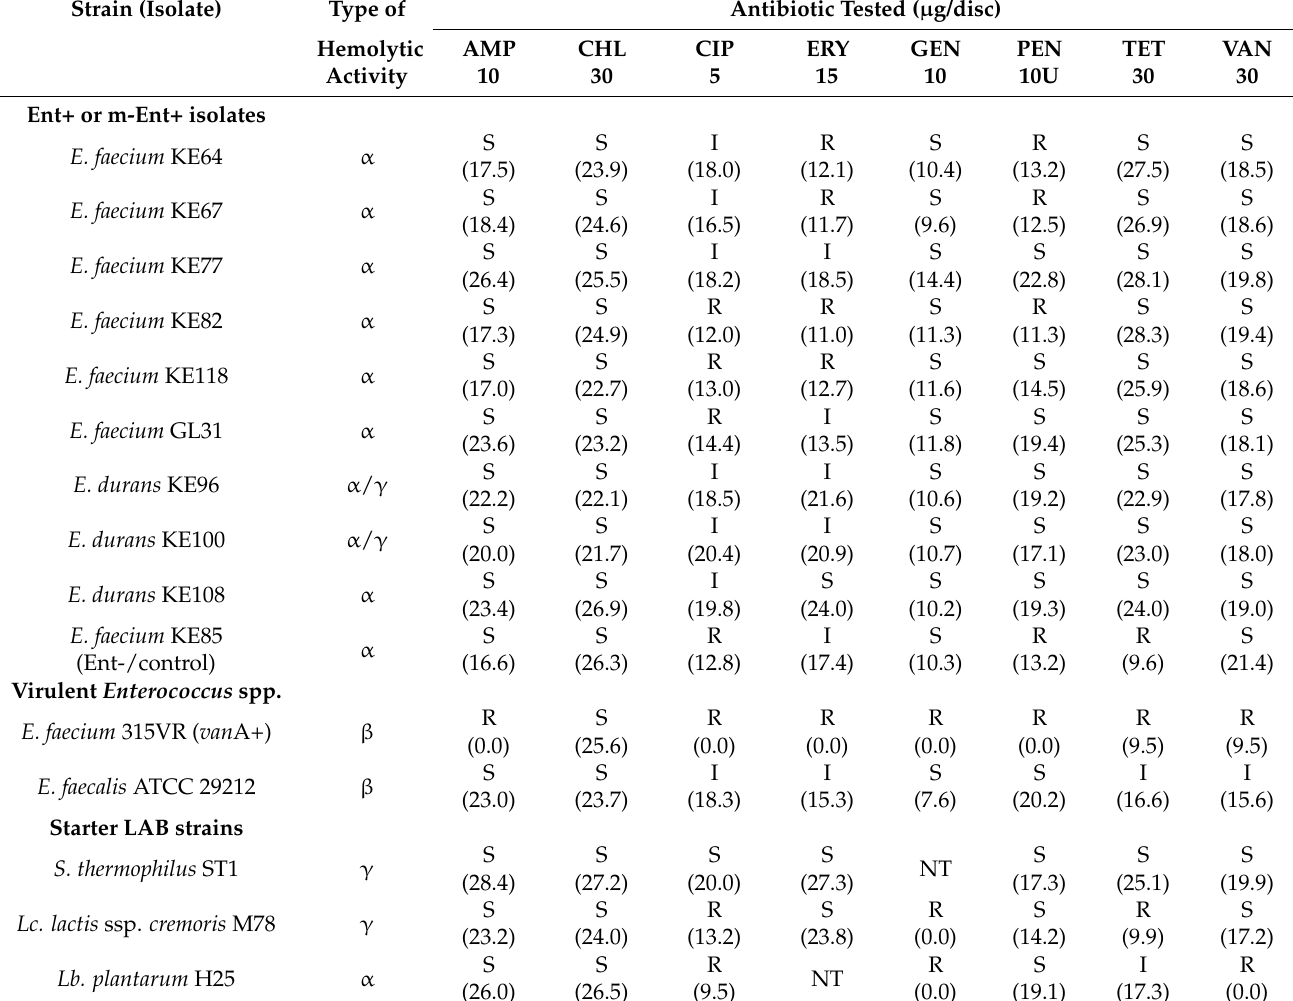
KE82, and KE85 strains were resistant to penicillin, whereas the remaining three E. faecium KE77, KE118, and GL31 strains and both strain genotypes of E. durans were susceptible to penicillin. Additionally, according to the CLSI protocol, all Enterococcus cheese isolates were resistant or of intermediate susceptibility to ciprofloxacin and erythromycin, despite being inhibited by the above antibiotics (11.0–20.9 mm), and none were highly resistant (no inhibition zone), while the 315VR clinical strain was (Table 3). Table 3. Hemolytic activity and antibiotic susceptibility of the Ent+ Greek cheese isolates of the E. faecium/durans group. Strain (Isolate) Type of Antibiotic Tested ( µ g/disc) Hemolytic